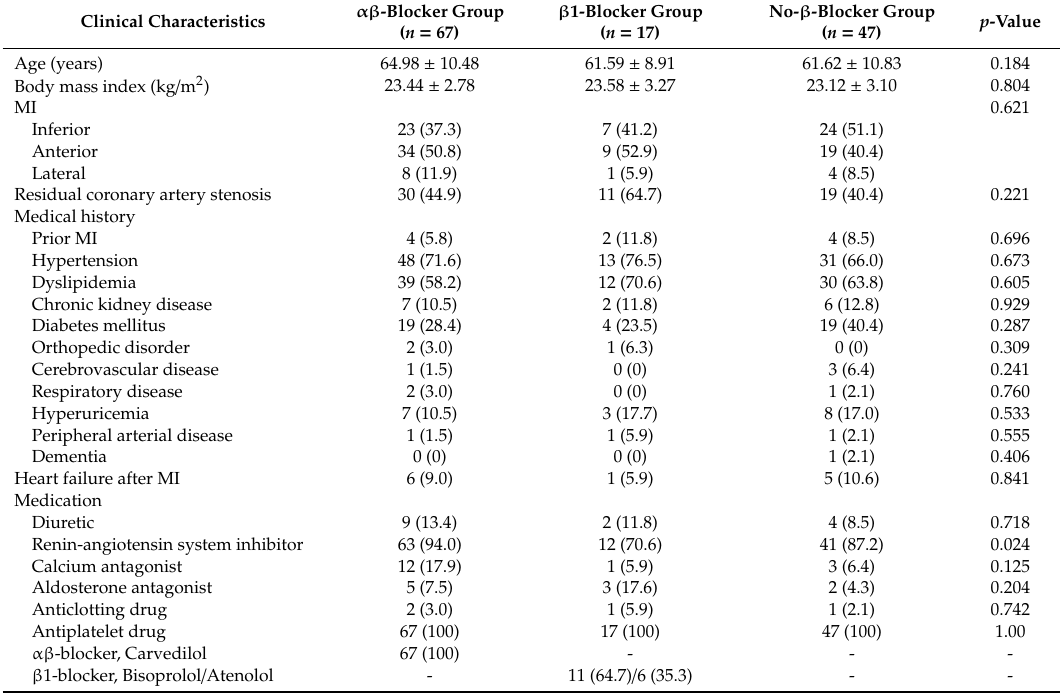
Table 1. Patient clinical